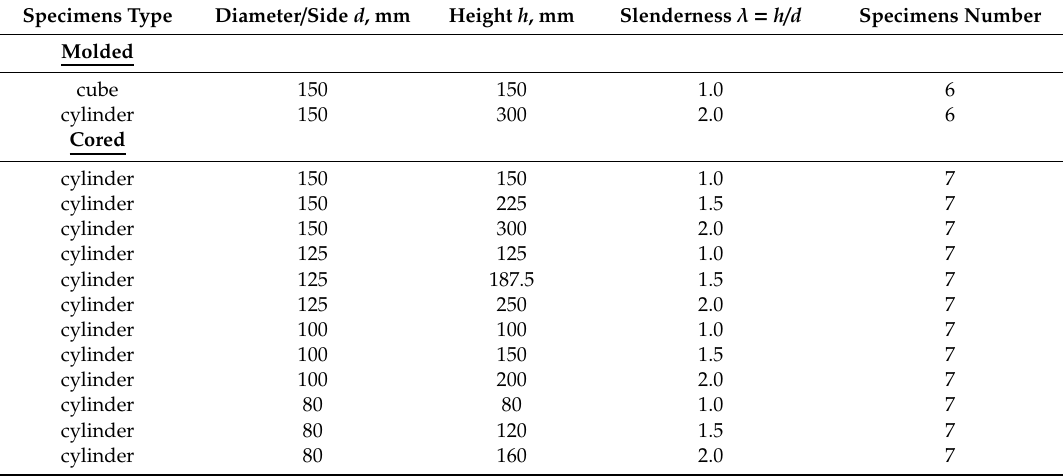
Table 3. The types and numbers of specimens prepared for the tests of each concrete series.